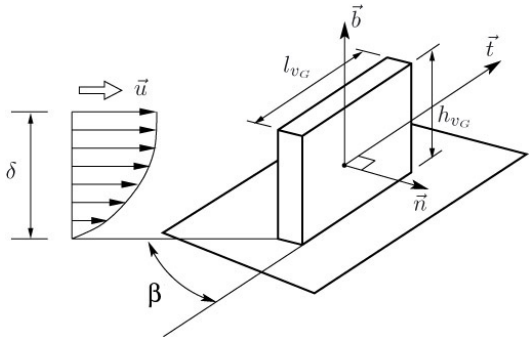
Figure 2. ( a ) The two VGs studied of heights H 1 = 0.8 δ and H 2 = 0.2 δ on the flat plate with δ representing the local boundary layer thickness at the upstream edge of the ramp (not at scale); ( b ) Configuration example of a pair of similar counter-rotating VGs with three measurement lines A, B and C past the VG.